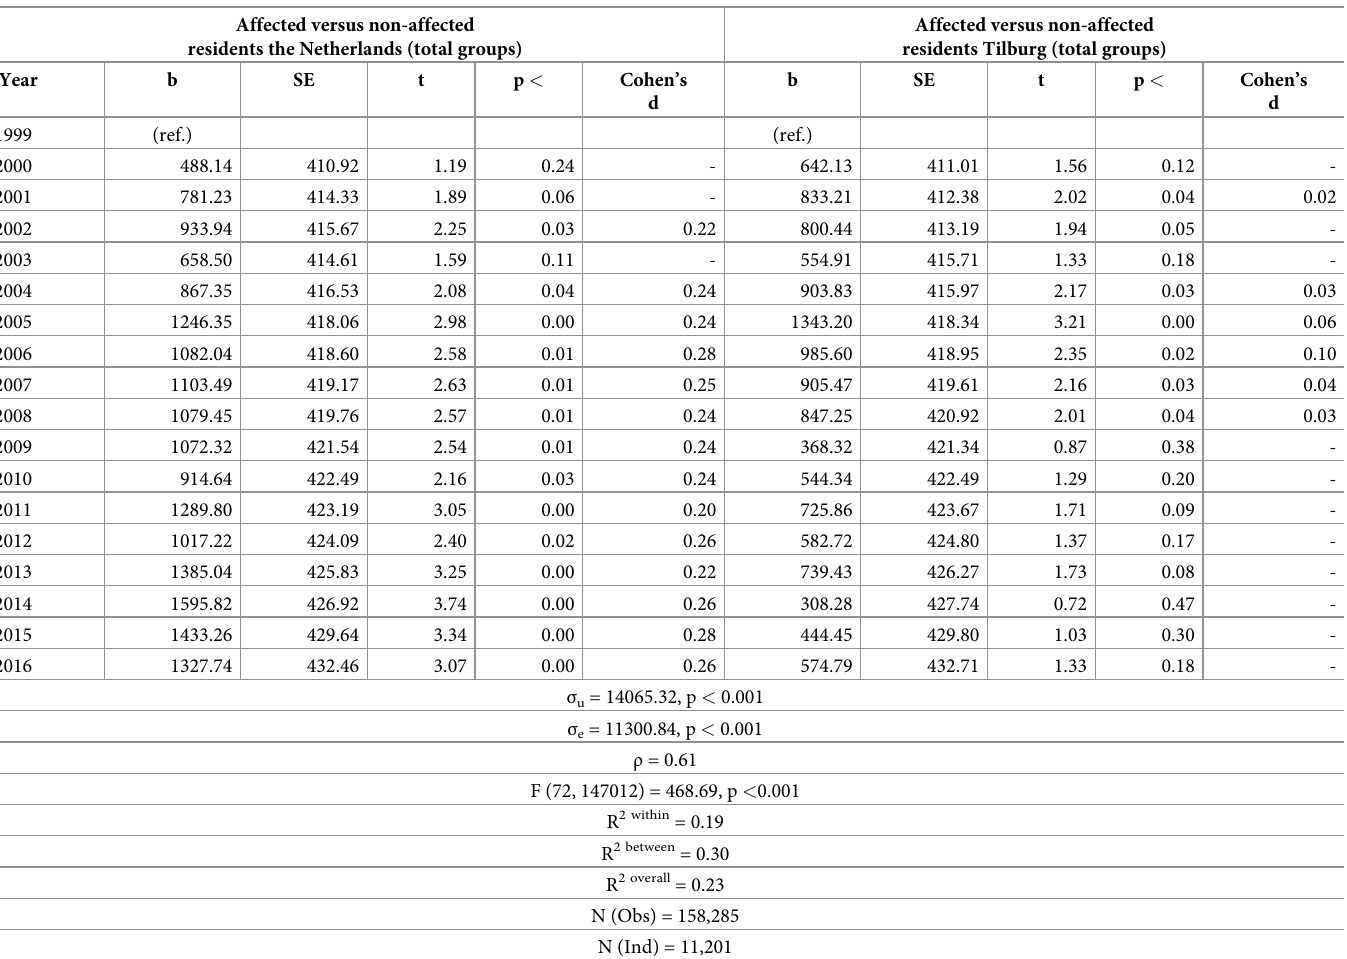
Table 2. Results of fixed-effects linear panel regression models for total groups with gross annual wages as dependent variable (1999–2016). Affected versus non-affected residents the Netherlands (total groups)